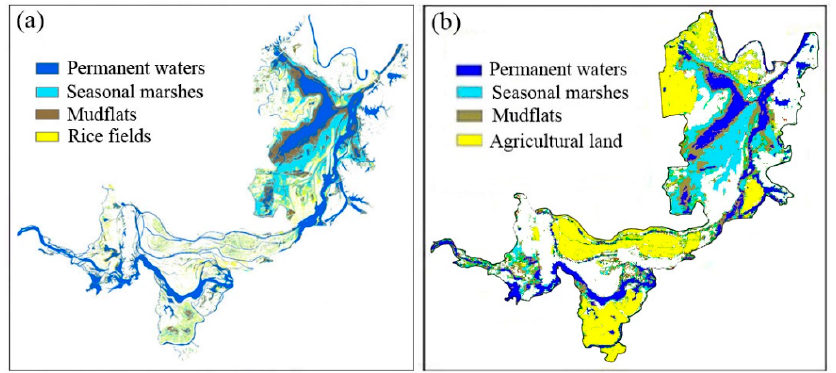
Figure 9. ( a ) Wetland classification of Dongting Lake based on water occurrences of the HSWDC. (The number of flooding 1 is defined as rice fields, 2–4 as seasonal marshes, 5–11 as mudflats, and 12 as permanent waters during one year). ( b ) Classification results of Dongting Lake from Chen et al. (2016).